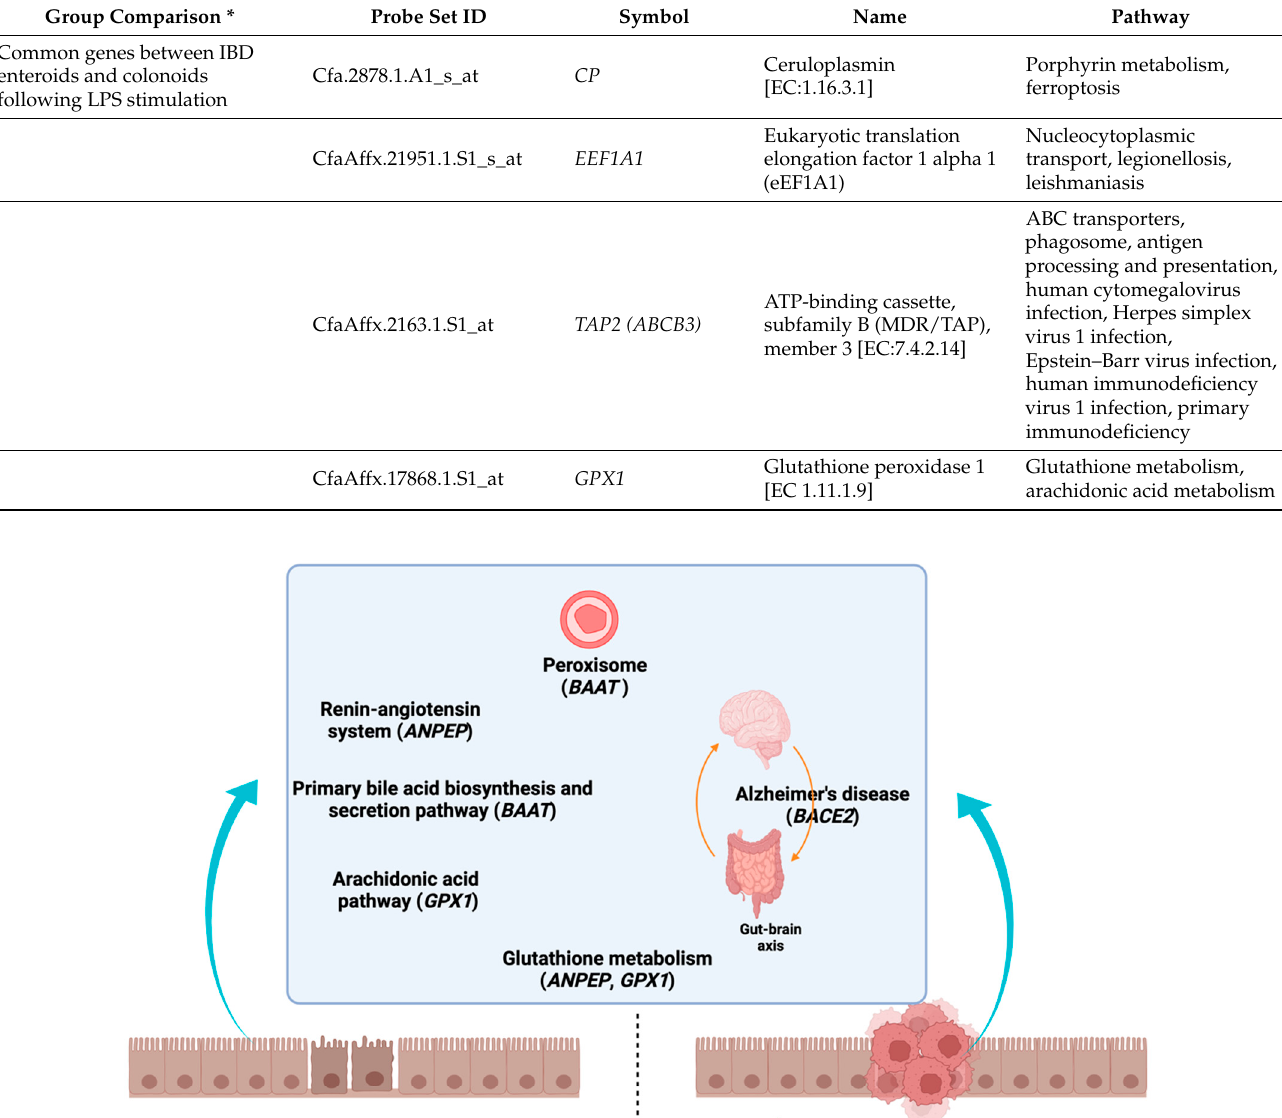
Table 15. The KEGG enrichment analysis results by Blast2GO [48]. The details of each KEGG path- way [45–47] are available at https://www.kegg.jp/kegg/kegg1.html. * Top upregulated and down- regulated genes were studied by Blast2GO [48]. Group Comparison *